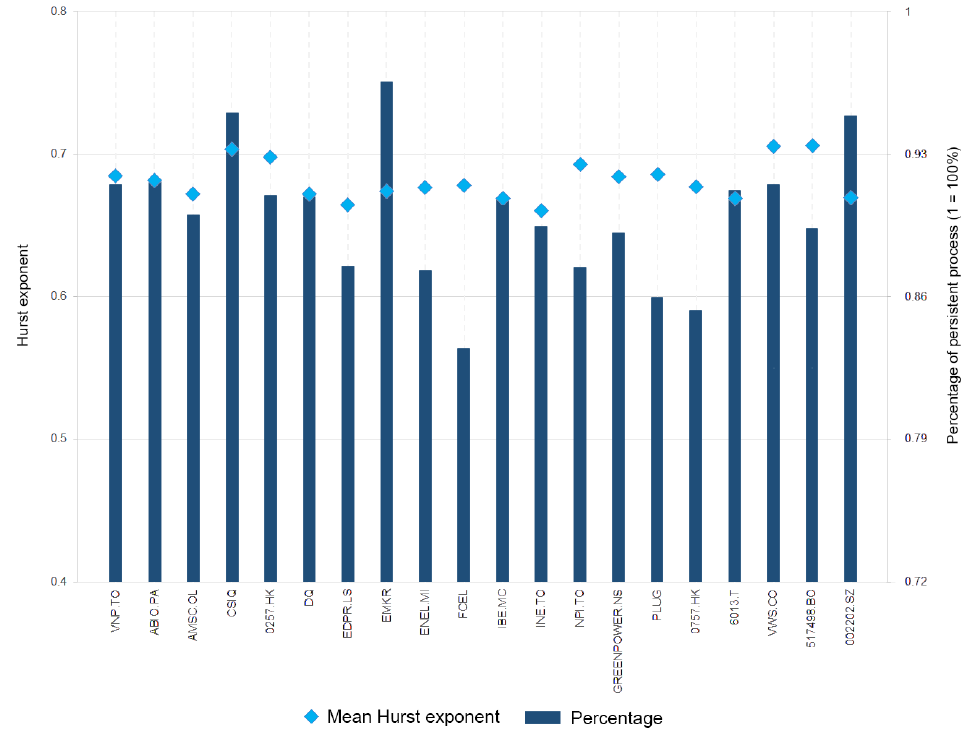
Figure 1. Mean Hurst exponents (H) and the percentage of persistent process occurrence of each component stock throughout the sample period. Random walk (efficient market) is when H = 0.5. Persistence (trend-reinforcing) is when 0.5 < H < 1.0, while anti-persistence (mean-reverting, cycling or contrarian) is when 0 ≤ H < 0.5.